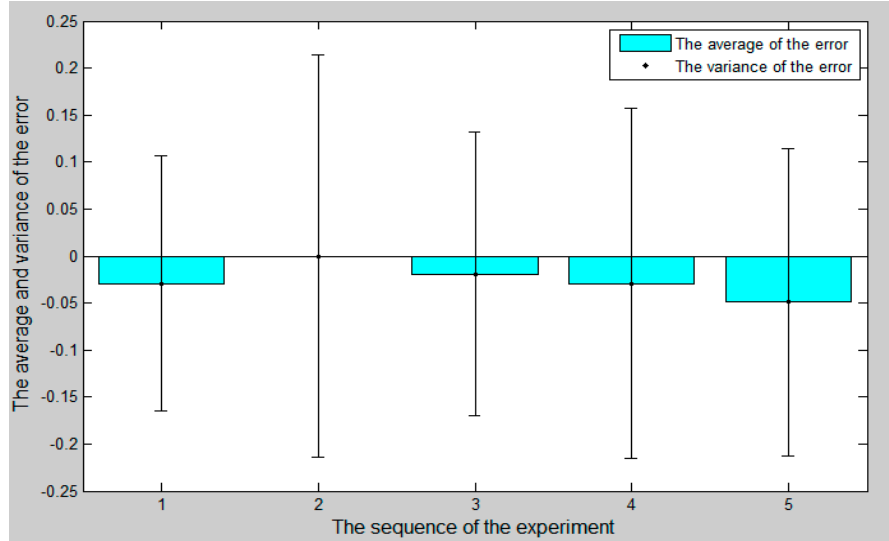
Figure 17. The master–slave axial displacement sequence of the experiment.